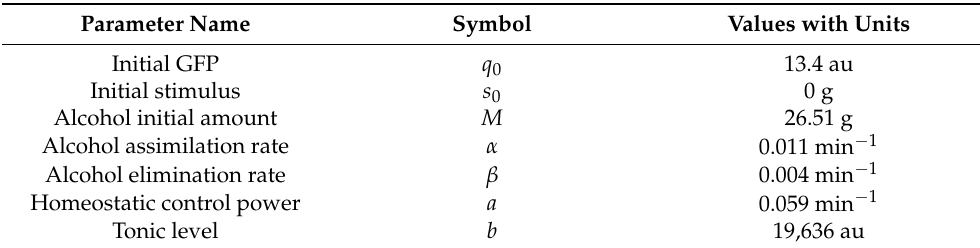
Table 5. Optimal parameter values, the Ermakov–Lewis energy and its initial kinetic and potential energies for the mean scores of the 28